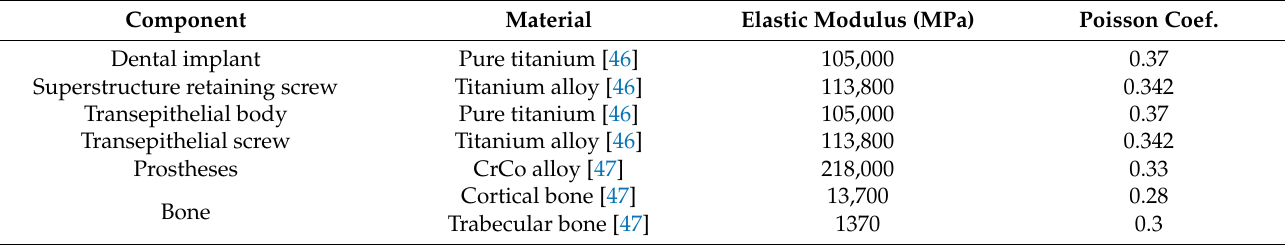
Figure 4. Boundary conditions and application of the load on the model. Table 2. Material and mechanical properties of the components.